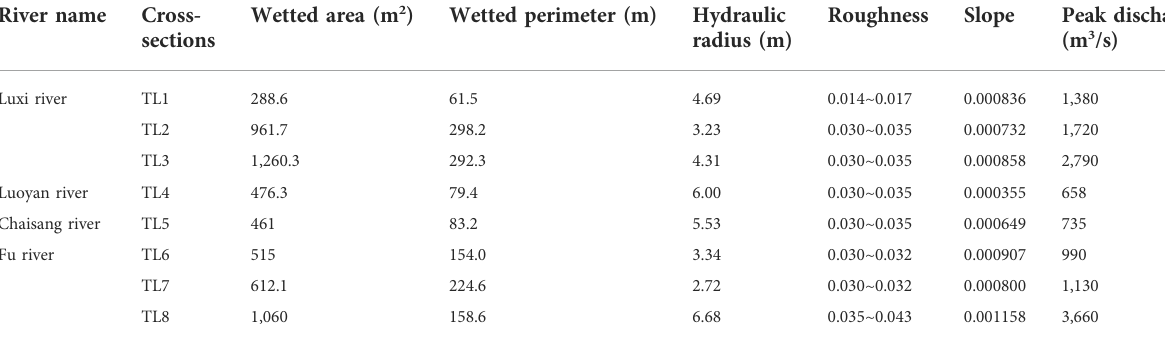
TABLE 5 Results of peak discharge by slope-area method.